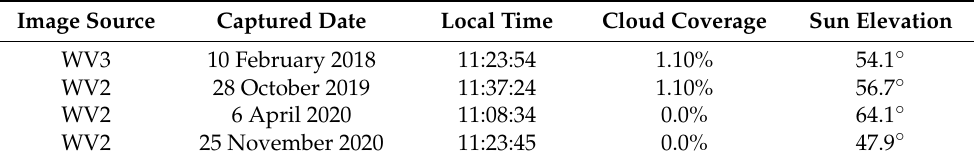
Table 1. Worldview dataset of Wuzhizhou Island.